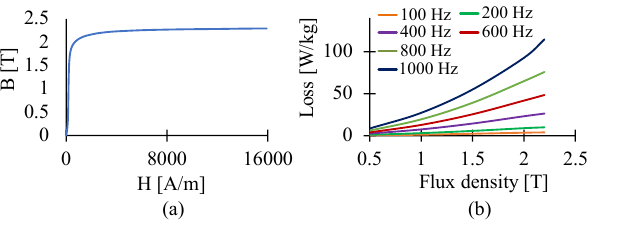
Figure 11. Characteristics of Hiperco-50 0.15 mm laminations: ( a ) BH characteristics and ( b ) specific core